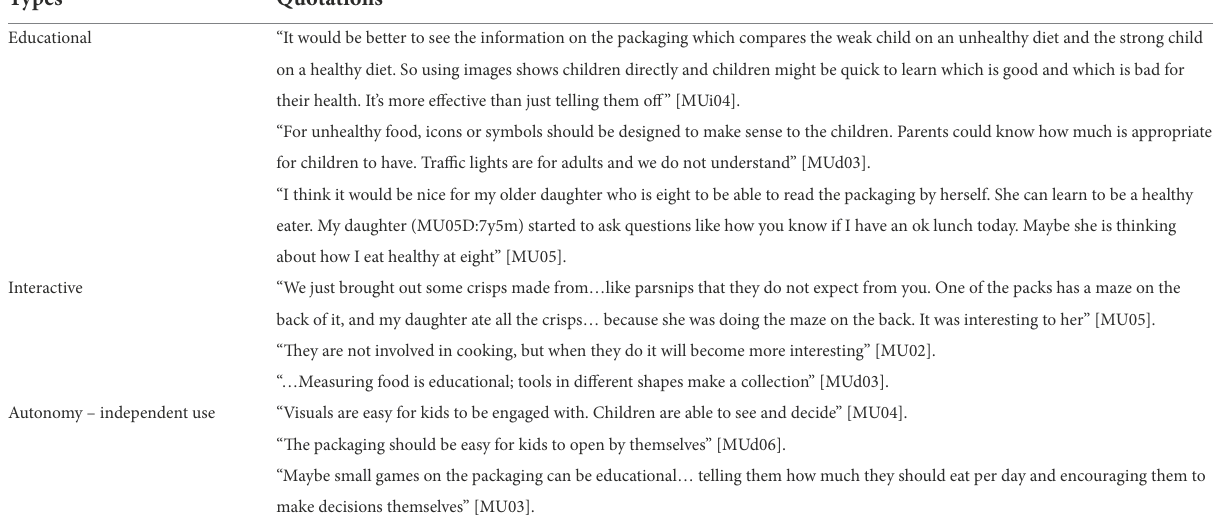
TABLE 3 Three types of creative packaging solutions for downsizing suggested by